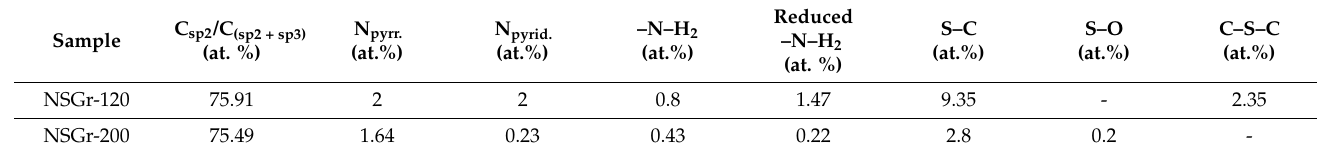
Figure 4. High-resolution XPS spectra of N1s lines of the investigated samples. Table 1. The sample compositions as determined by